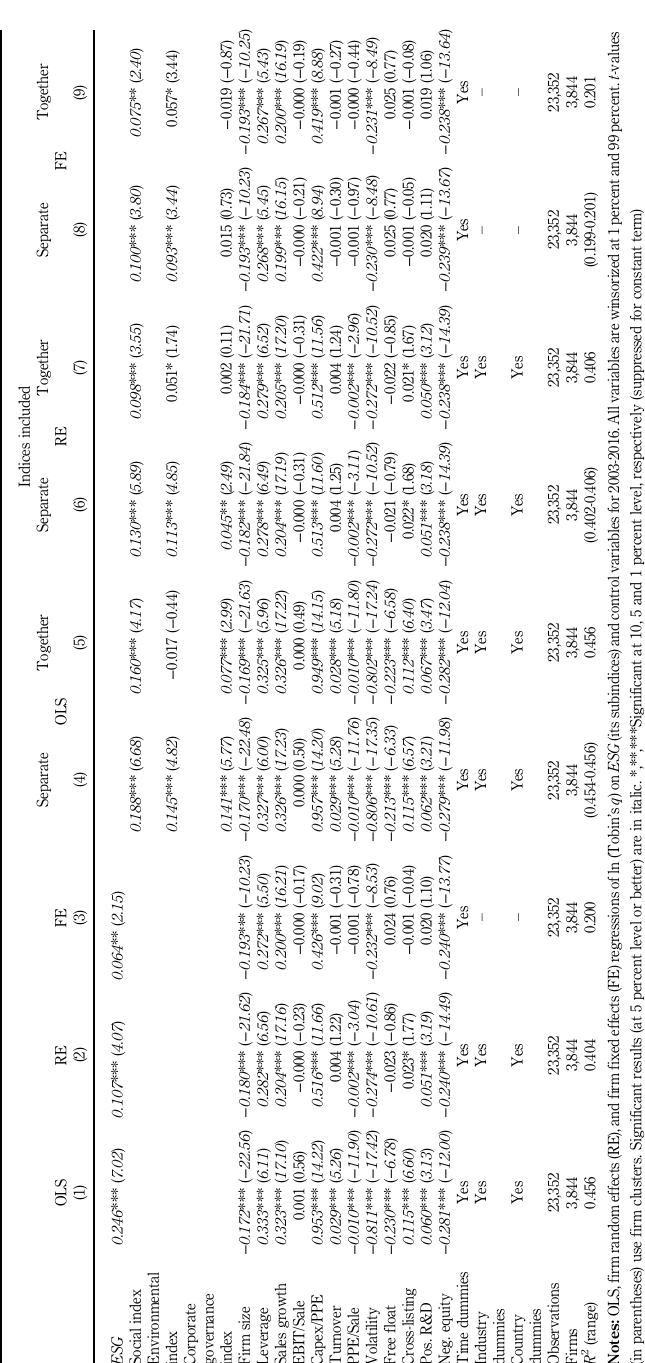
Table V. Overall ESG , its indices, and firm